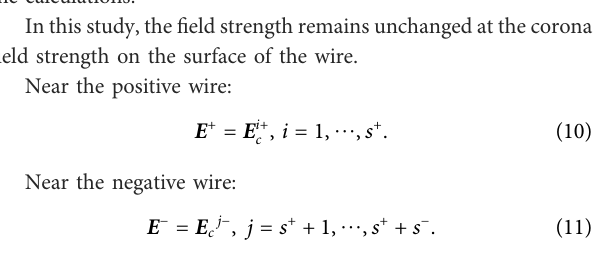
FIGURE 4 Schematic diagram of electric fi eld interpolation distributed based on